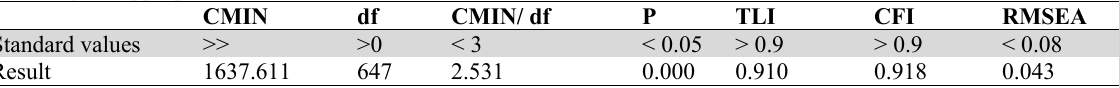
The impact of the independent variables on the dependent variable Impact